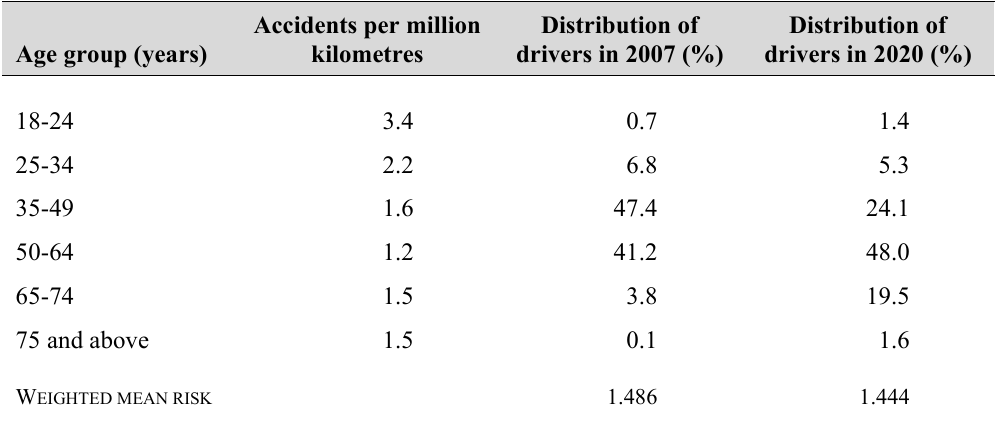
Table 1 Changes in the age distribution of licence holders for heavy goods vehicles Accidents per million Distribution of Distribution of Age group (years) kilometres drivers in 2007 (%) drivers in 2020